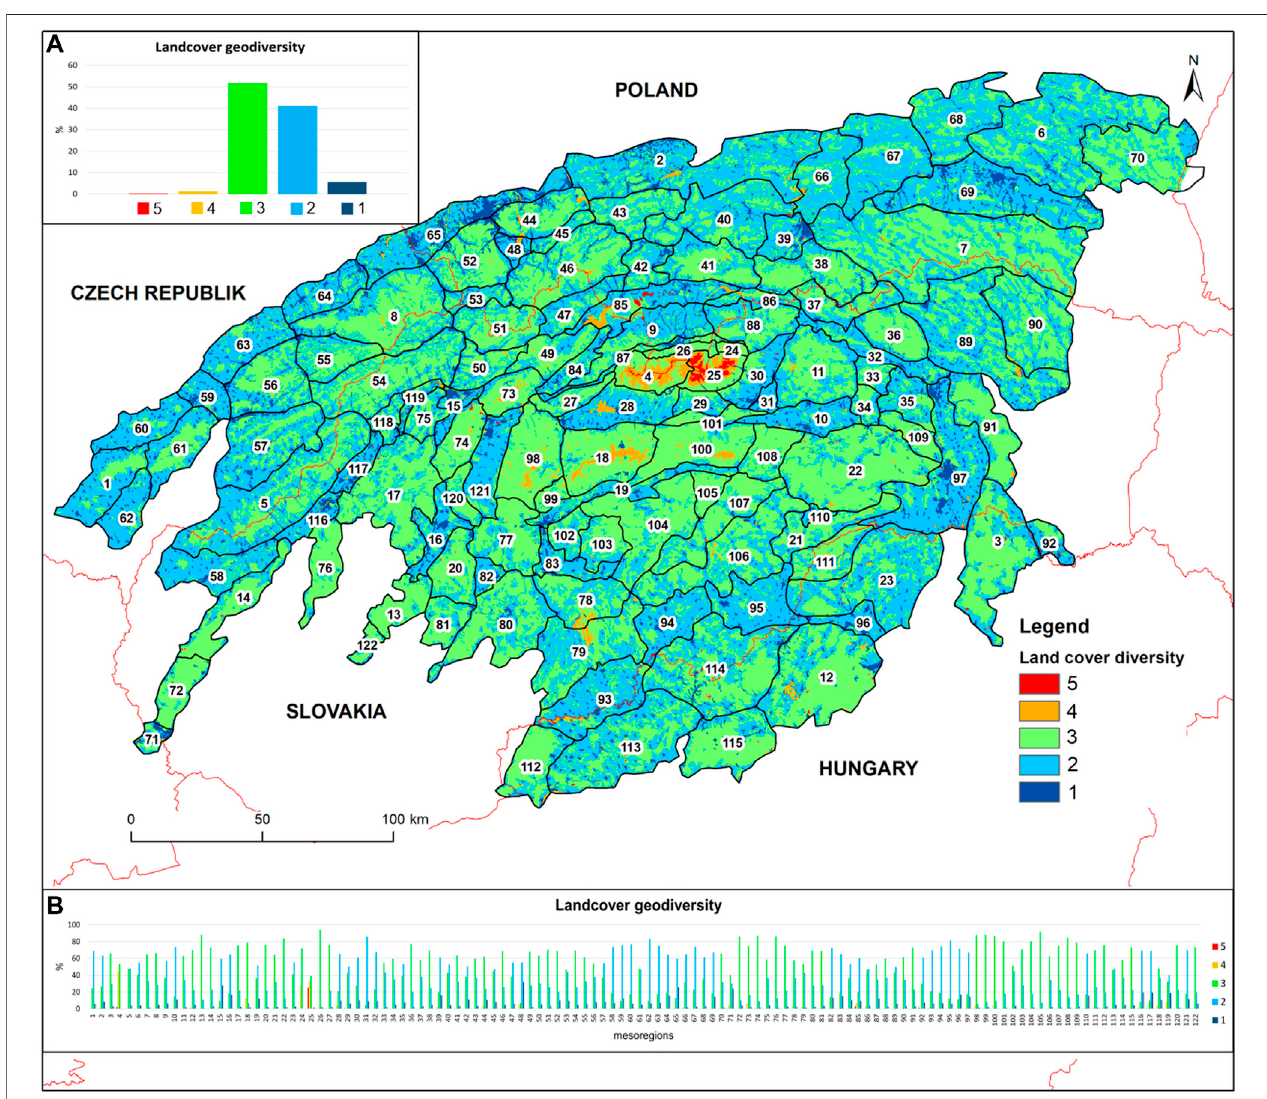
FIGURE 7 | Landcover geodiversity map. 5: rocks, peat bogs, and quarries; 4: pastures and meadows; 3: forests, shrubs, and arable lands; 2: buildings; 1: industrial areas. For numbers of mesoregions, see Figure 2 . Source: own research.